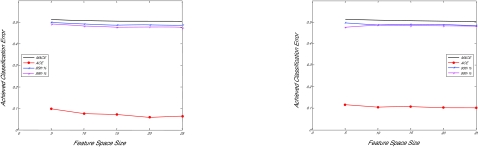
PACE analysis using a SVM-based classifier using the t-test scoring criterion, with a 0.6 MAC threshold. Left Panel: performance without peak selection. Right panel: performance with peak selection.